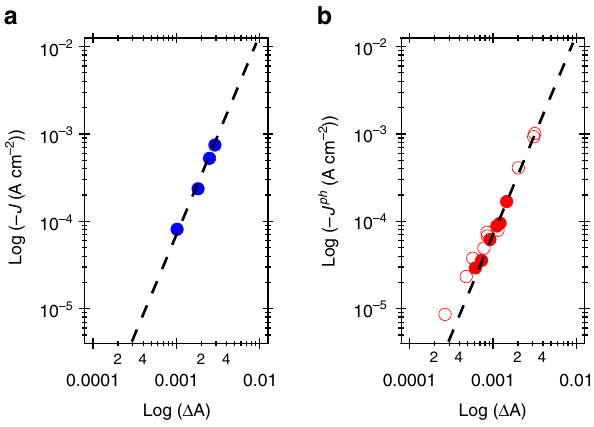
Figure 6 | Relationship between (photo)current and absorbance changes. ( a ) Current-absorbance characteristics of the RuO x electrocatalyst represented as the log [ (cid:2) J ] versus the absorbance of the catalytic RuO x species at different applied potentials ( (cid:2) 0.05 to (cid:2) 0.2V versus RHE). ( b ) Photocurrent-absorbance characteristics of the photocathode represented as the log [ (cid:2) J ph ] versus the photoinduced absorbance of the catalytic RuO x species generated at 0.1V versus RHE upon 365nm illumination at different photon fluxes ( B 0.5 to 1.5mWcm (cid:2) 2 ). The regression of log [ (cid:2) J ] versus log [ D A] yielded slopes of 2.1 ± 0.1 (correlation coefficient, R ¼ 0.997) for the electrocatalyst. For the photocatalyst two sets of data are shown, collected with (empty circles, see Supplementary Fig. 8) and without (solid circles, see Fig. 5) the addition of 0.01M surfactant (Tritron X-100) used to promote facile bubble release. The independent data sets have been normalized to be plotted in the same graph. The regression of log [ (cid:2) J ph ] versus log [ D A] of each dataset yielded identical slopes of 1.9 ± 0.1 ( R ¼